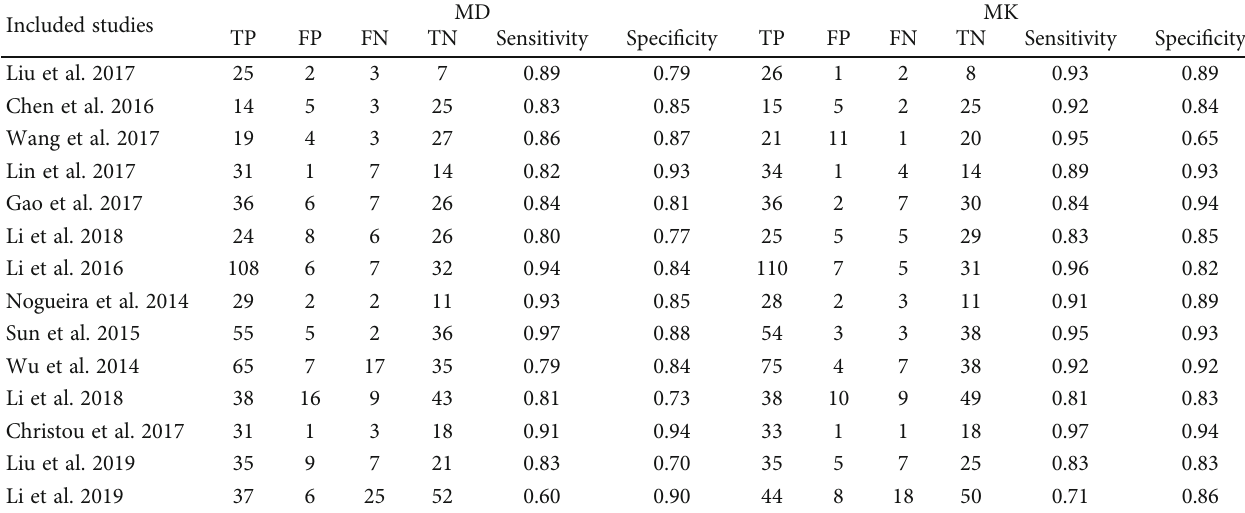
Table 3: Diagnostic performance of MD and MK for the included studies.